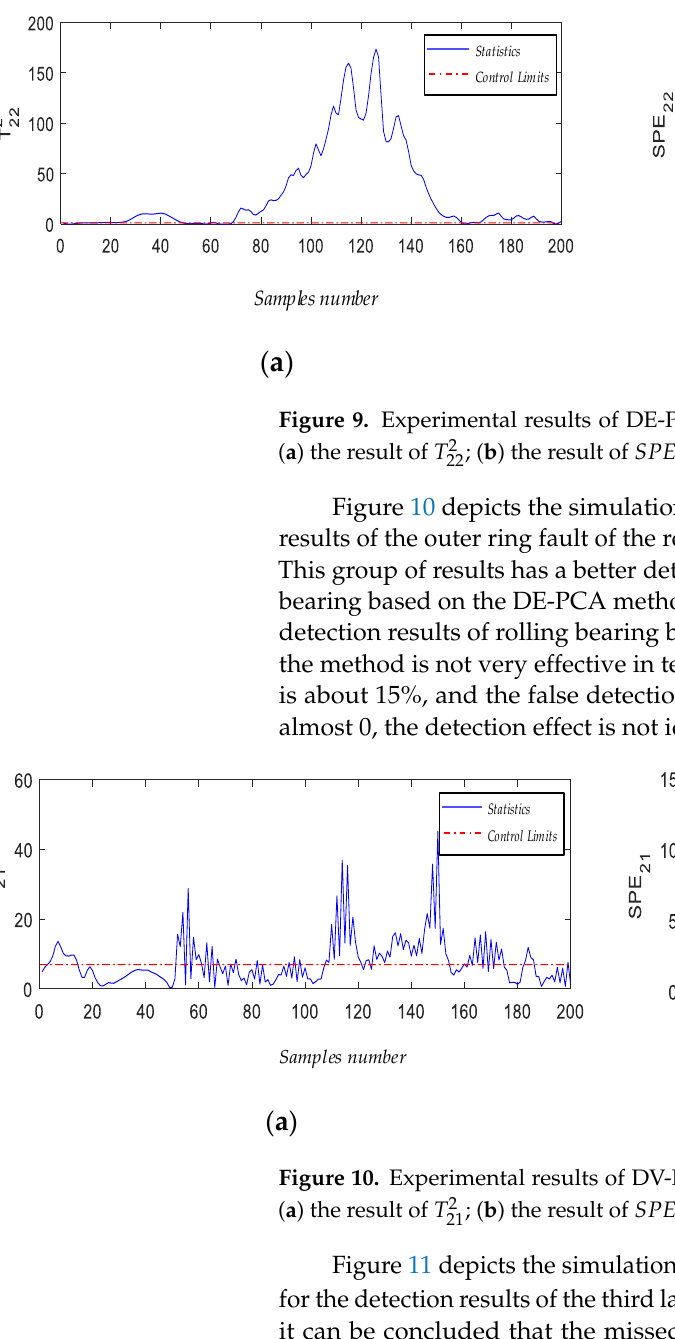
Figure 10. Experimental results of DV-PCA fault detection method for rolling bearing outer ring: T ; ( b ) the result of SPE . ( a ) the result of 2 21 21